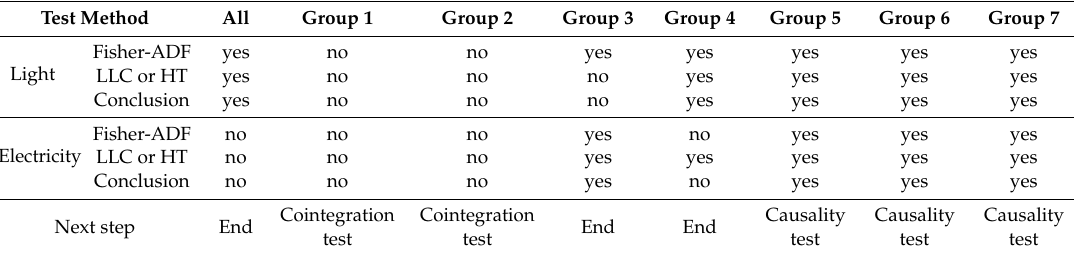
Table 6. Summary of stationarity